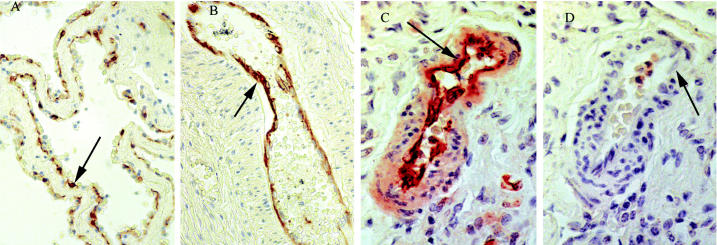
CYP1A1 expression in lung and bladder endothelium from beluga whale. CYP1A1 is labeled pink to dark red; arrows indicate cells with labeling and the identical cell type without labeling. (A) CYP1A1 expression in lung endothelium from an Arctic beluga. (B) CYP1A1 expression in bladder endothelium from an arteriole from an Arctic beluga. (C) CYP1A1 expression in lung endothelium from an Arctic beluga. (D) Serial section from Arctic beluga shown in (C) was labeled using the nonspecific antibody UPC-10. Magnification: A, C, D, 400×; B, 200×.